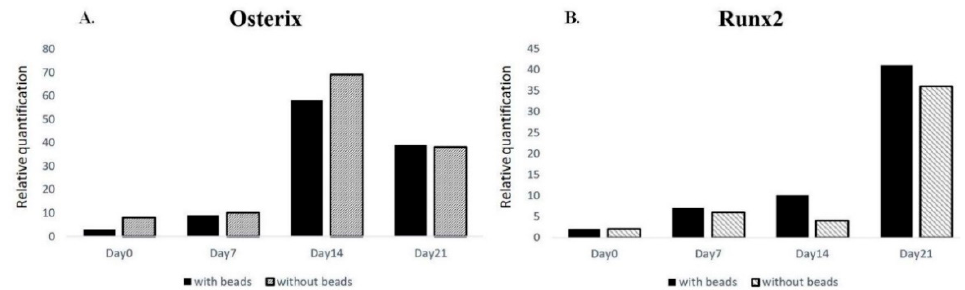
Figure 4. Injected fluorescent beads did not influence hMSCs osteogensis. No significant difference was present in marker gene expressions, ( A ) Osterix and ( B ) Runx2, in cells with or without fluorescent particles.